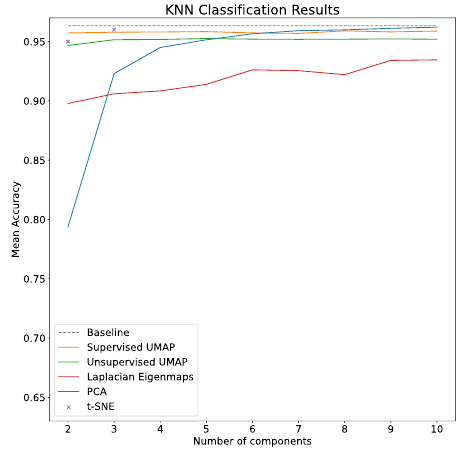
Figure 5. Mean accuracy for the KNN classification of embedded test data via UMAP, PCA, LE and t-SNE. Results are shown over increasing dimensions of